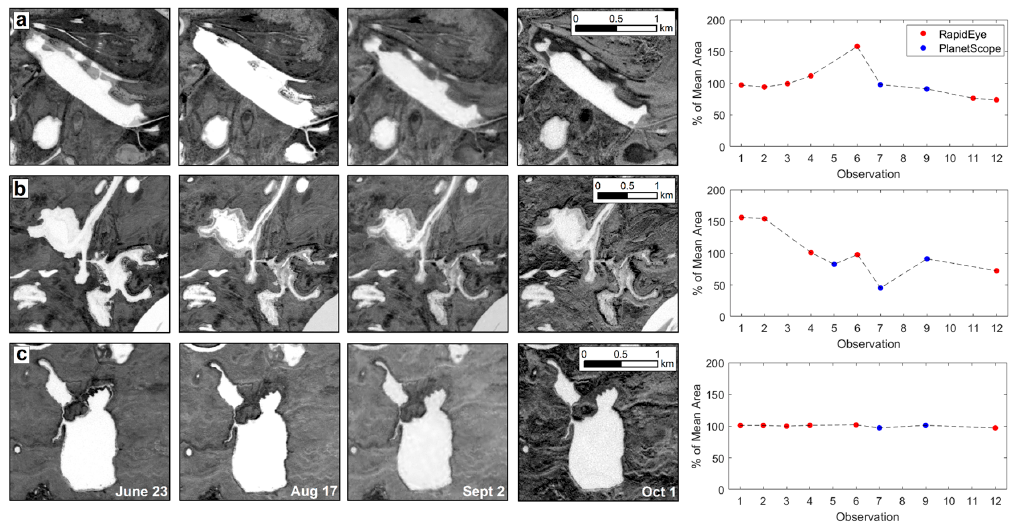
Figure 8. Examples of lake area time series categorized as: ( a ) connected; ( b ) disconnected and ( c ) stable. The time series of lake area is shown on the right. Column 1 is NDWI imagery from 6/23 (observation 1), column 2 from 8/17 (observation 5), column 3 from 9/02 (observation 9) and column 4 from 10/01 (observation 12).